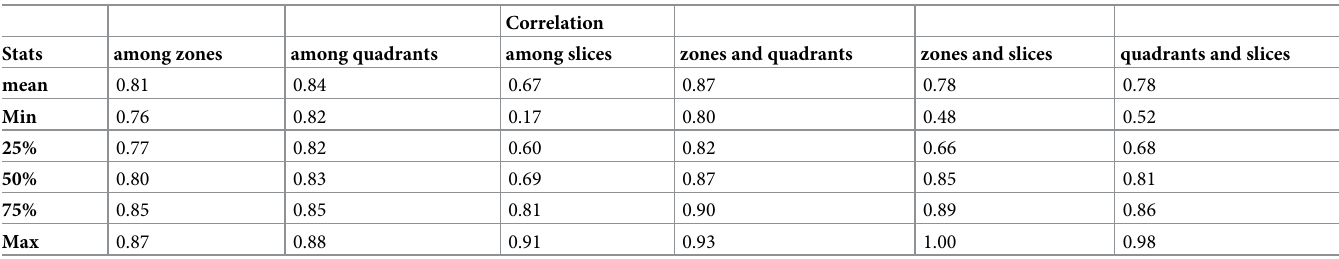
Table 4. Pearson correlation among the sixteen coefficients (3 zone, 4 quadrants, 9 slice coefficients).